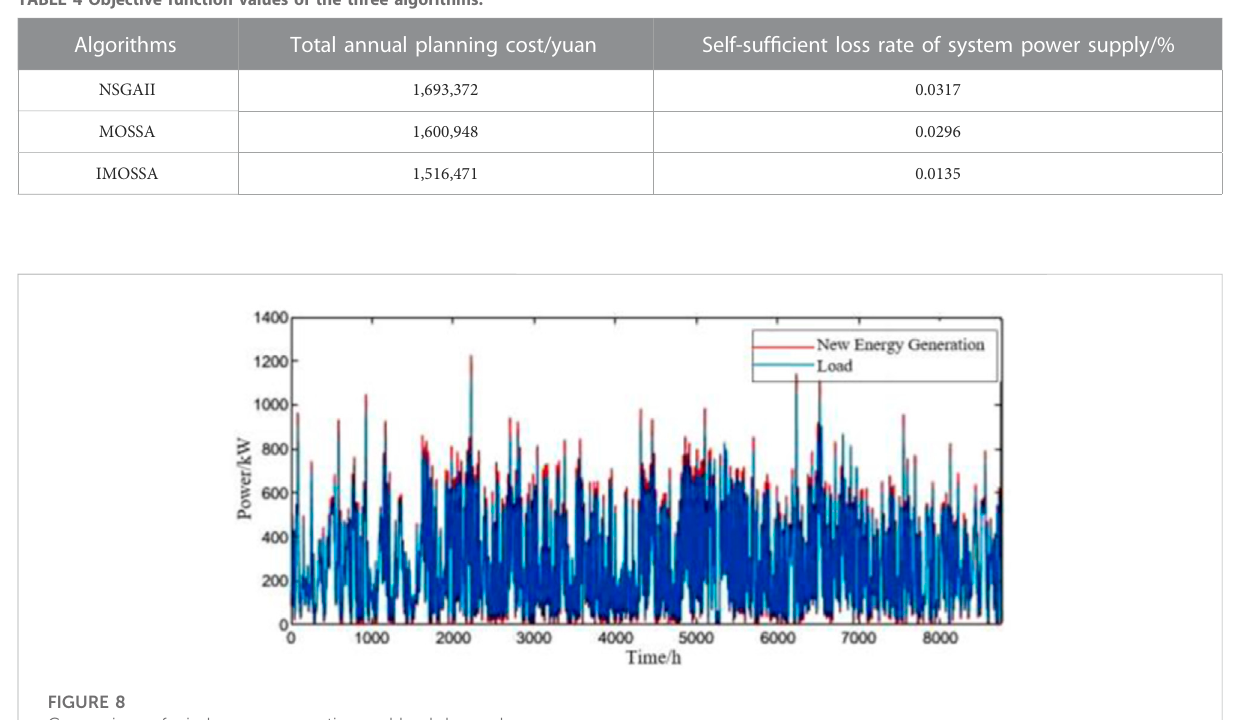
FIGURE 8 Comparison of wind power generation and load demand.